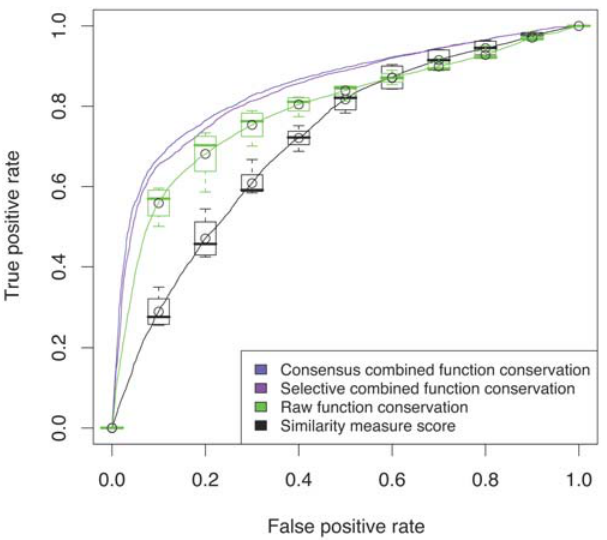
Figure 5. Comparing Similarity Scores to Raw and Combined Function Conservation Scores. The ROC plot serves to analyze the reliability when inferring GO level three functional annotations from the nearest protein neighbors. For each protein domain, nearest neighbors are sought according to the four similarity measures (CE, TM, LP, GP). The GO terms attached to these nearest neighbors can be potentially inferred for a query protein. By sorting annotation transfers according to the similarity scores and evaluating the true positive rate versus the false positive rate, a ROC curve is derived.The black curve displays the average ROC curve for the four similarity measures (CE, TM, LP, GP); the boxplots attached serve to estimate the observed spread. Similarly, when sorting according to raw function conservation scores, we obtain four ROC curves, the average of which is shown as green curve along with the estimated spread as boxplots. Merging the information into a combined consensus score yields one score per inferred annotation; The corresponding ROC curve is plotted in violet for selective combination and in blue for consensus combination. doi:10.1371/journal.pcbi.1000105.g005 Table 1. Evidence Codes Used by the Gene Ontology Annotation Project.